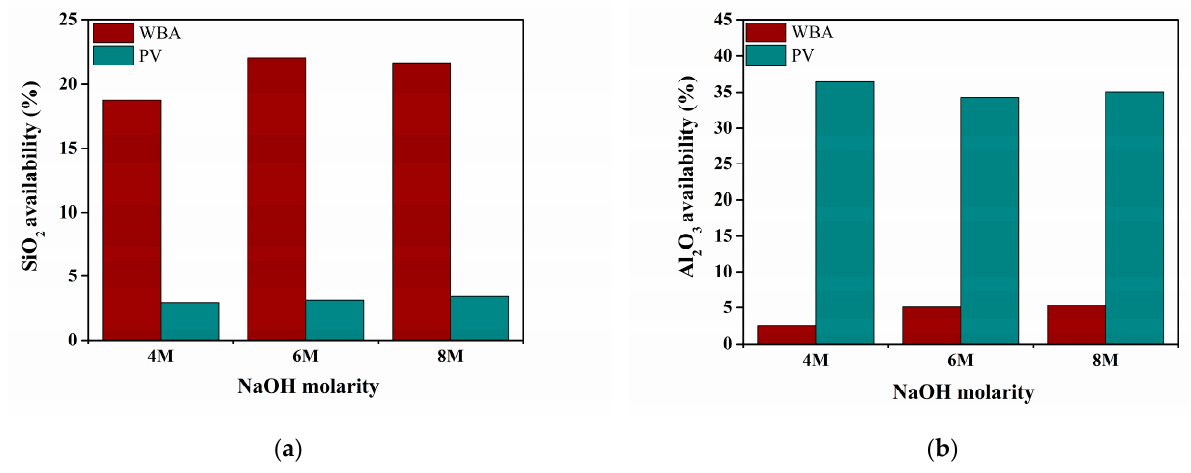
Figure 2. SiO 2 and Al 2 O 3 availability percentage in ( a ) WBA and ( b ) PV samples. X-ray diffraction (XRD) analysis of the WBA and PV was conducted with a Bragg– Brentano Siemens D-500 powder diffractometer (Siemens, Munich, Germany) with CuK α radiation. The main crystalline phases detected in the WBA were quartz (SiO 2 ; PDF# 01-079-1910) and calcite (CaCO 3 ; PDF# 01-083-1762), as shown in Figure 3a. Other minor phases such as dolomite (CaMg(CO 3 ) 2 ; PDF# 01-075-1759), akermanite (Ca 2 Mg(Si 2 O 7 );